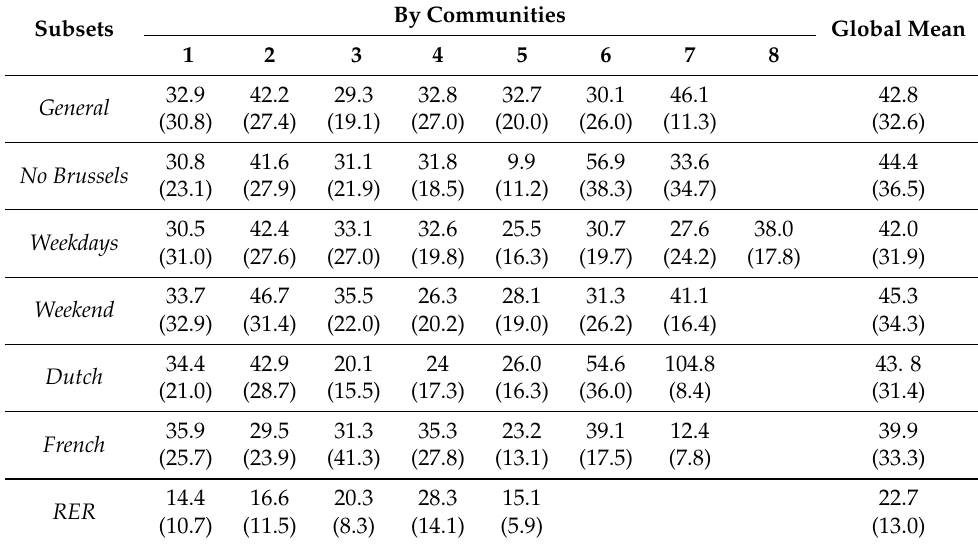
Table 3. Average travel distance alongside the railway network (km; between bracket = standard deviation). By Subsets